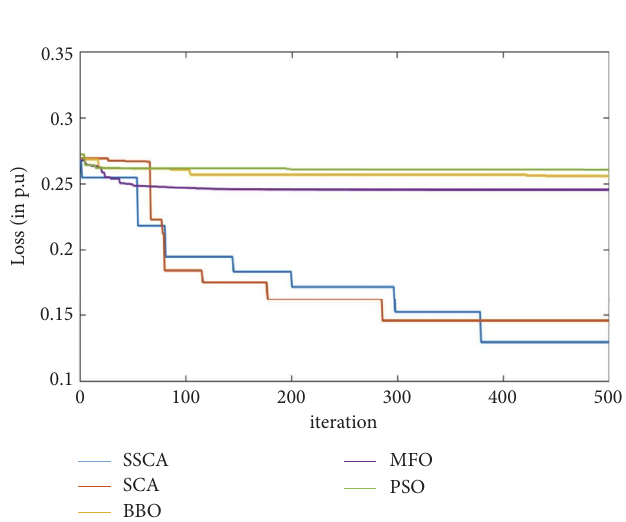
Figure 6: Loss variation in the IEEE-57 bus system at 100% loading.